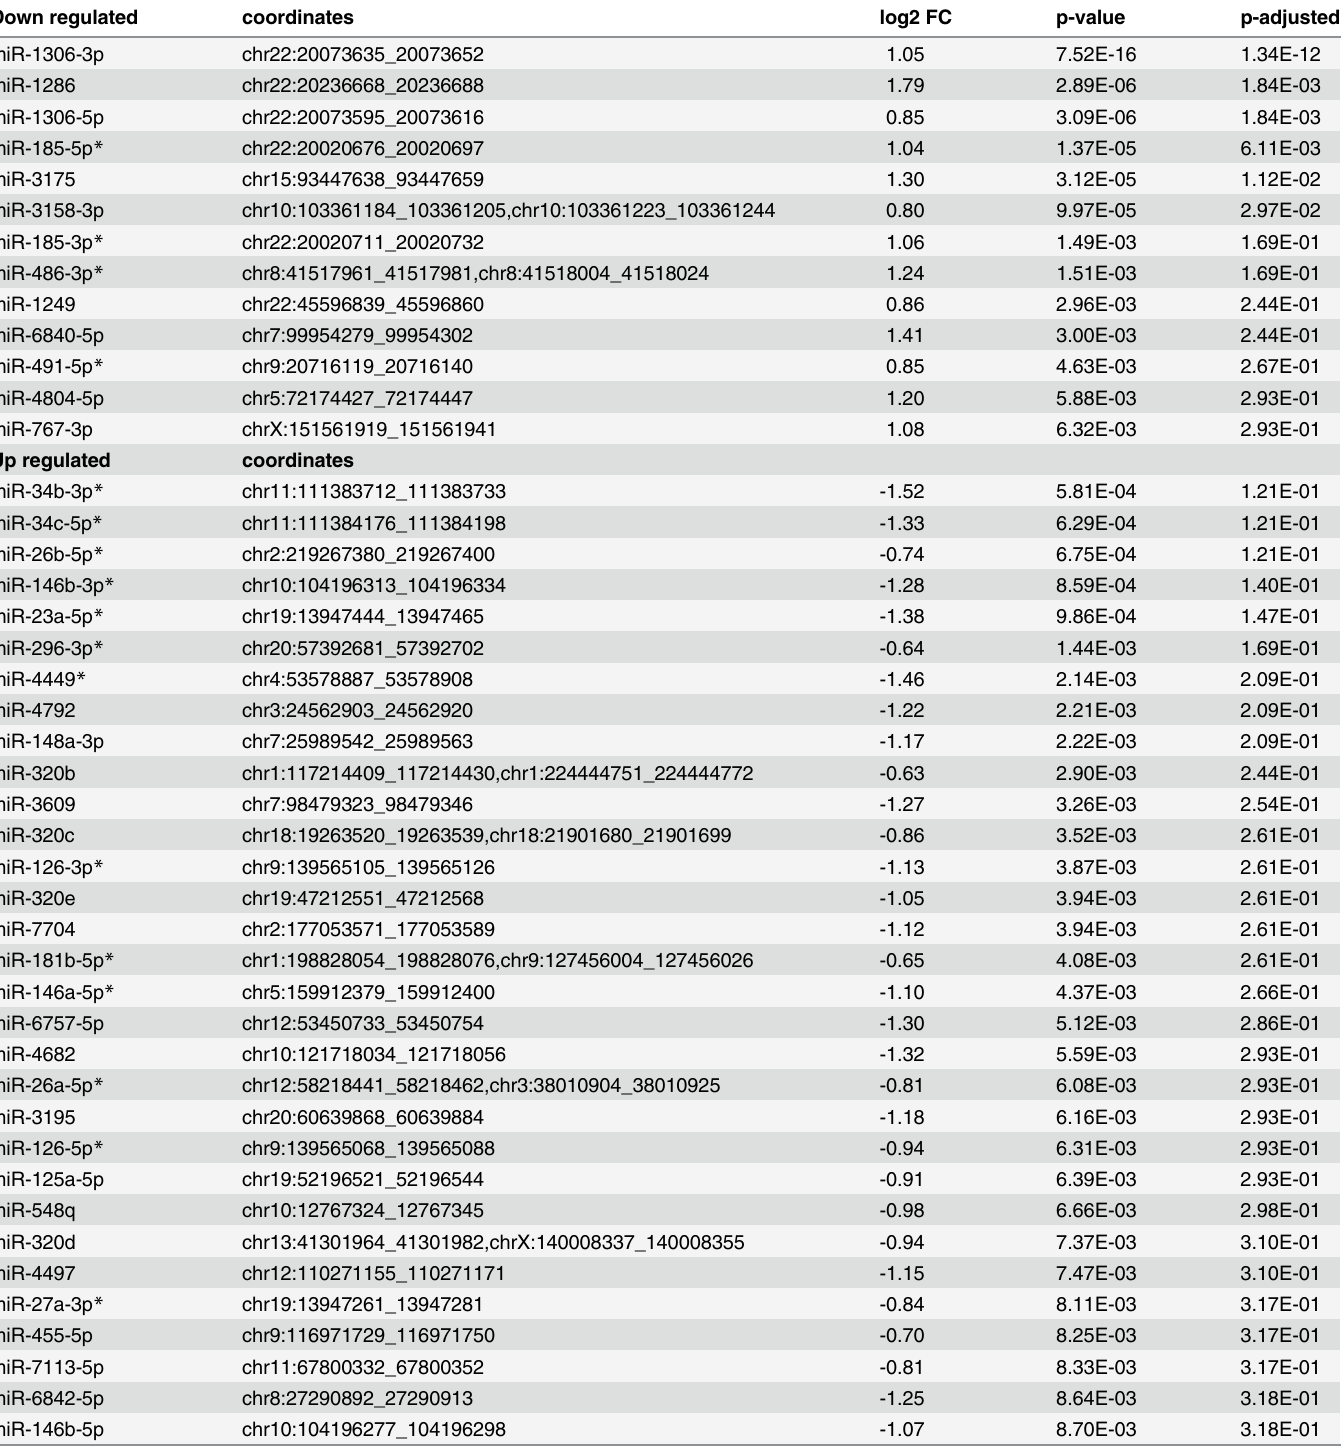
Table 2. Differentially expressed